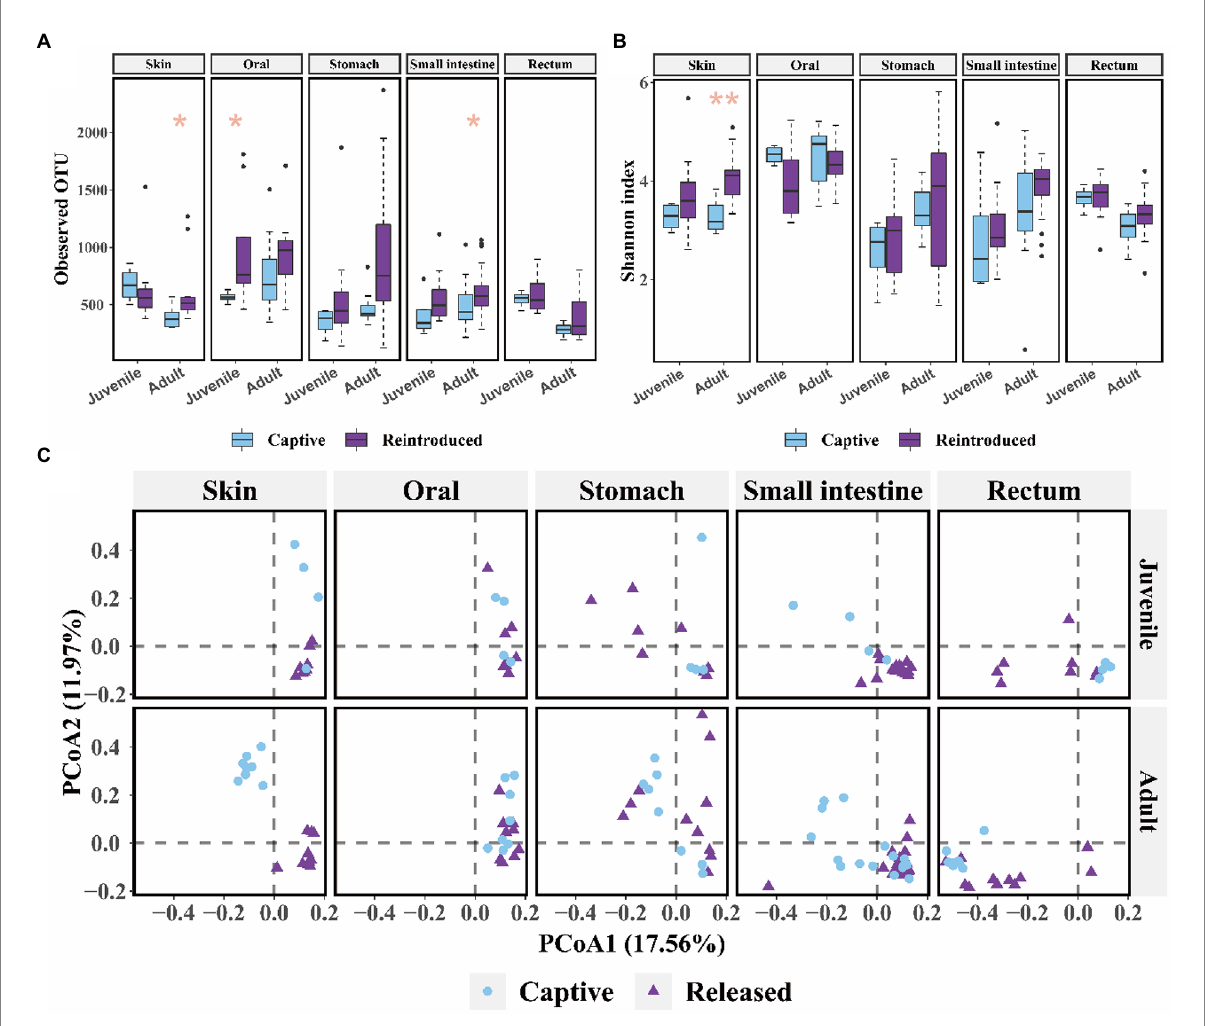
FIGURE 3 The comparison of alpha and beta diversity between captive bred and released CGSs symbiotic microbiota. (A) Boxplot of observed OTU values; (B) Boxplot of Shannon diversity values. Data are presented as means ± SE, and significant differences are marked with an asterisk; (C) PCoA scatter plots present the dissimilarity of microbiome at the OTU level, based on weighted Unifrac